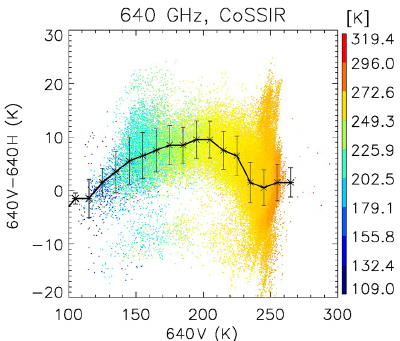
Figure 5. Scatter plot of quality-controlled CoSSIR PD–TB VV 640GHz measurements from the TC4 campaign. Observations over land and ocean are not separated here. The black solid line with er- ror bars is the PDF peak, where bins beyond 260K are excluded because of the sparseness of the